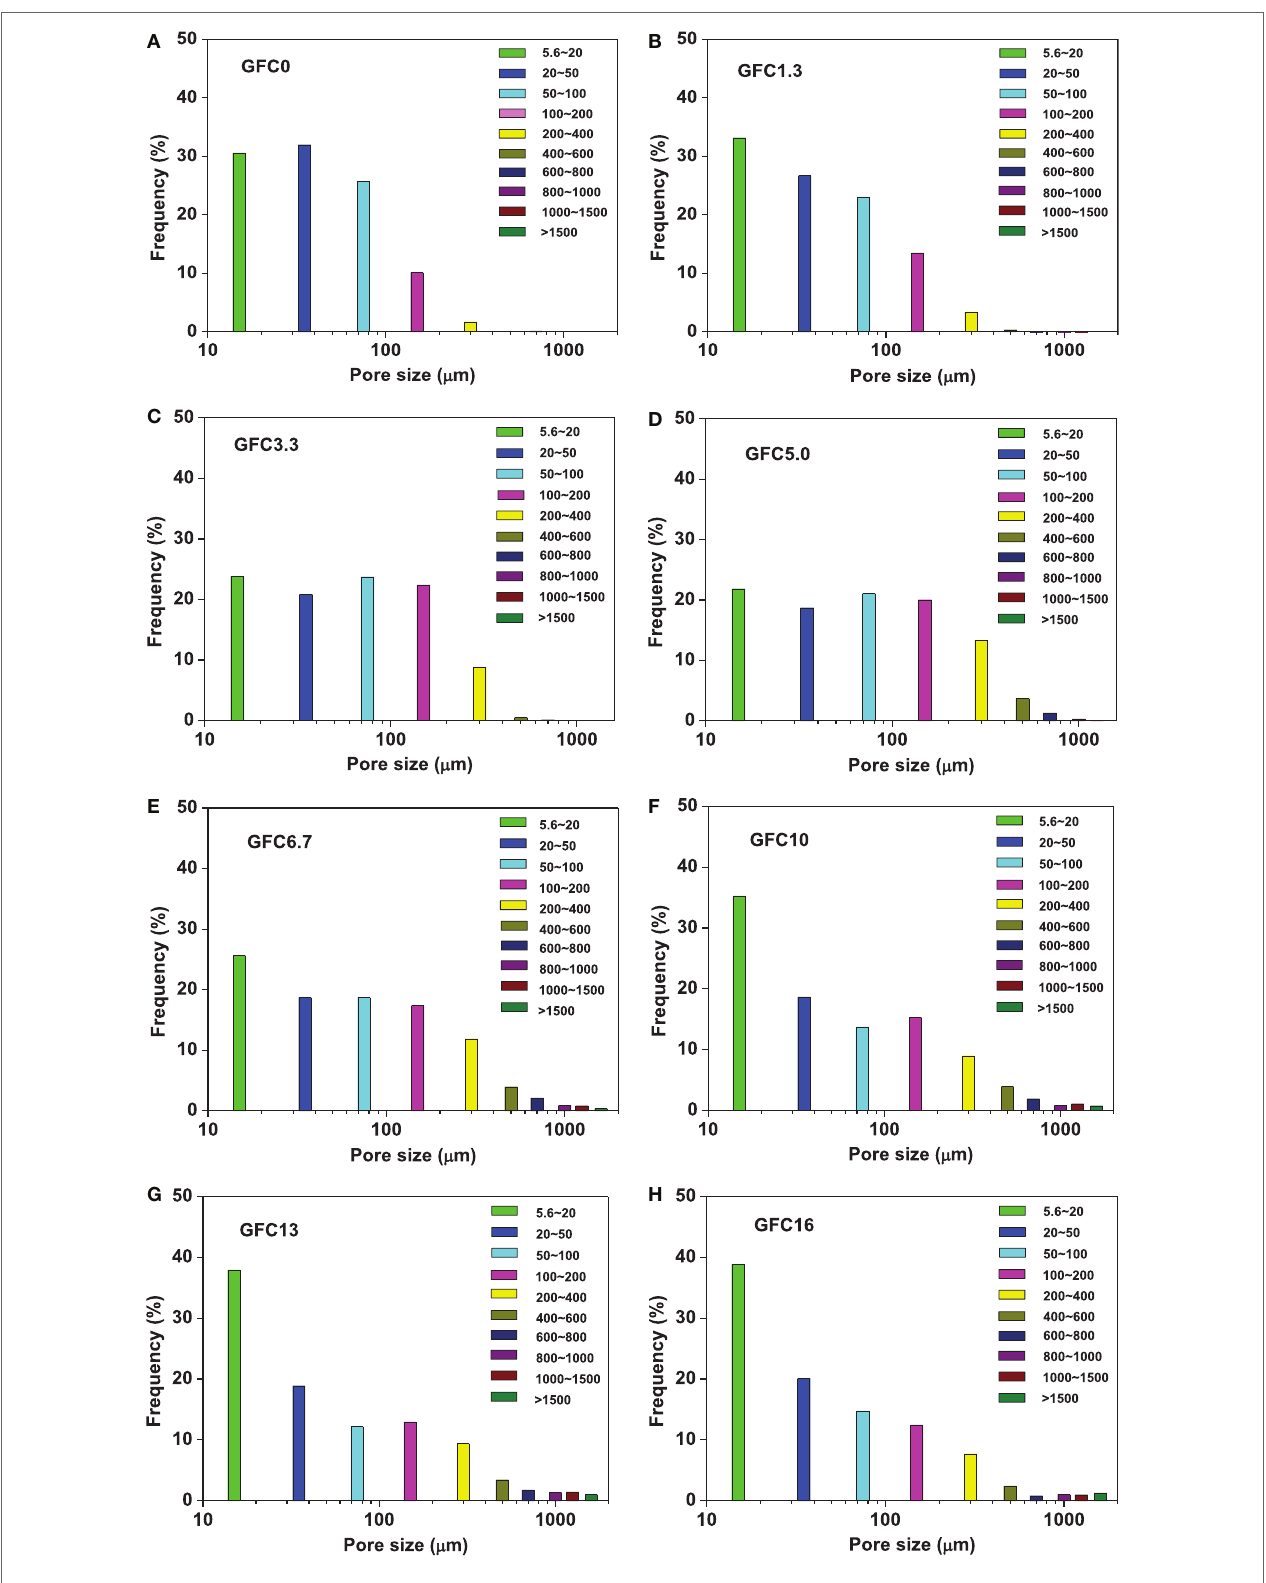
FigUre 3 | Frequency of detected pores (or voids) in gFcs with 0% (a), 1.3% (b), 3.3% (c), 5% (D), 6.7% (e), 10% (F), 13% (g), and 16% (h) of foam addition in respect of solid raw materials .